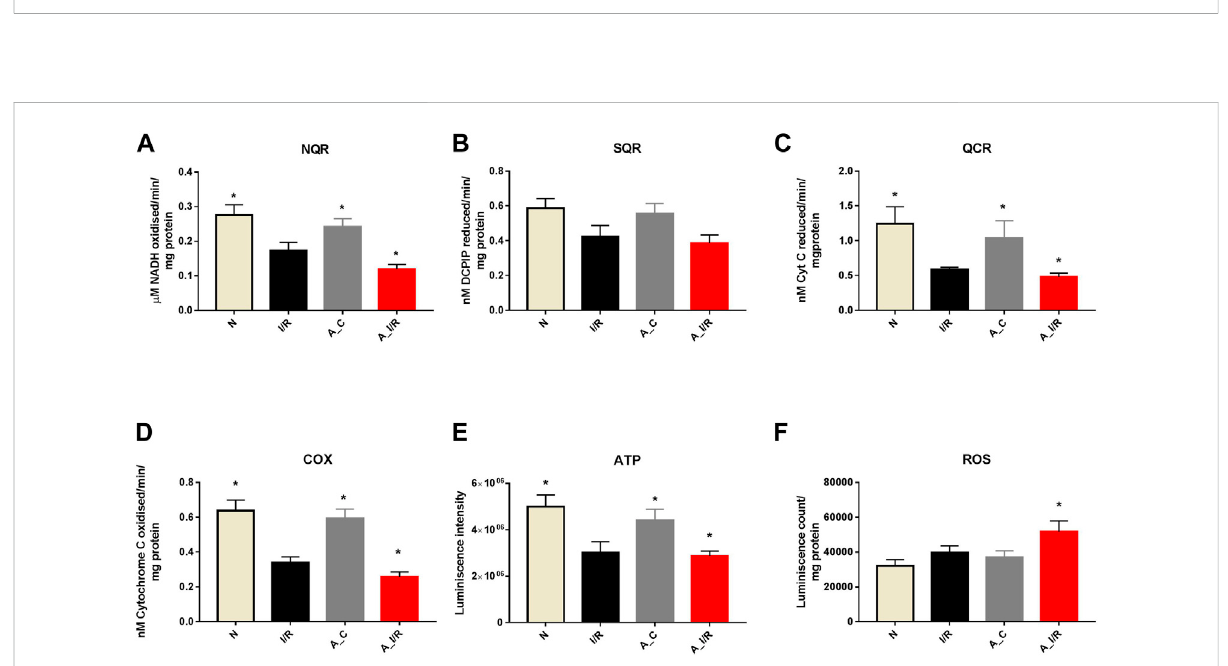
FIGURE 4 Assessmentof mitochondrial function in young and adultI/R hearts:The impactof I/R on mitochondrialfunctional activities inyoung and adult heartswereassessedbyevaluatingtheelectrontransportchainactivitiesof (A) ComplexI(NQR); (B) ComplexII(SQR); (C) ComplexIII(QCR);and (D) Complex IV (COX); (E) ATP content; (F) ROS levels. The graphs represent mean ± SD values. *p < 0.05 vs. I/R